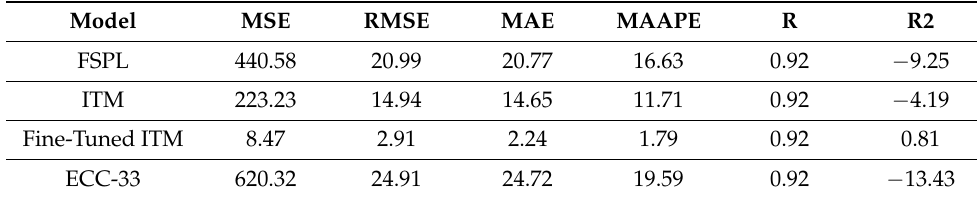
Figure 12. ( a ) Measured PL vs. predicted PL from FSPL (baseline) and two Cloud-RF ® -based PL models. ( b ) Measured PL vs. predicted PL from FSPL (baseline) and fine-tuned ITM PL model. ( c ) Actual vs. predicted PL correlation scatter plot for the fine-tuned Cloud-RF ® -based ITM PL model. Table 4. Considered PL models’ accuracy evaluation metrics.